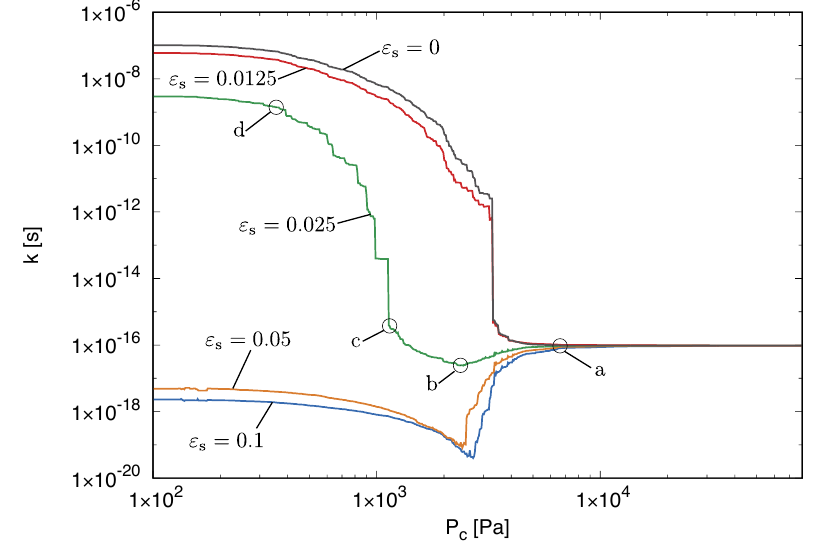
Figure 8. Constrained swelling analysis: conductivity versus capillary suction for the large network. The labels a, b, c and d mark stages at which the spatial distribution of quantities within the cell is